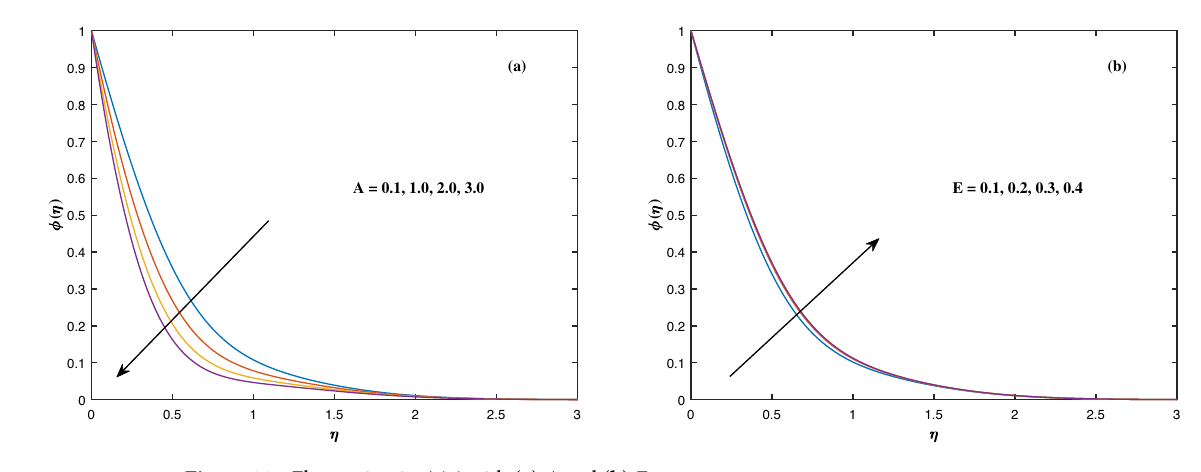
Figure 11. Fluctuation in φ(η) with ( a ) A and ( b ) E .